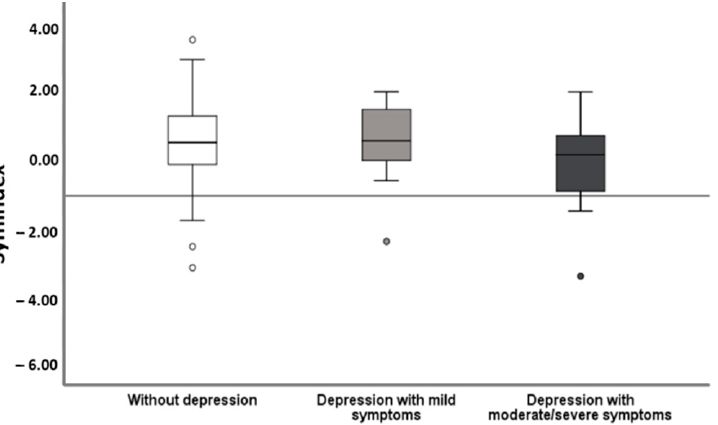
Figure 1. Heart rate variability in relation to severity of depressive symptoms. Patients with moderate/severe MDD presented with significantly lower HRV measured as the Symindex compared to those lacking depression ( p = 0.008) and those with mildly symptomatic MDD ( p < 0.049). In multivariate analysis, the Symindex remained as an independent predictor ( p = 0.013) of moderate/severe MDD, even after adjustment for sex, age and disease complexity (Table